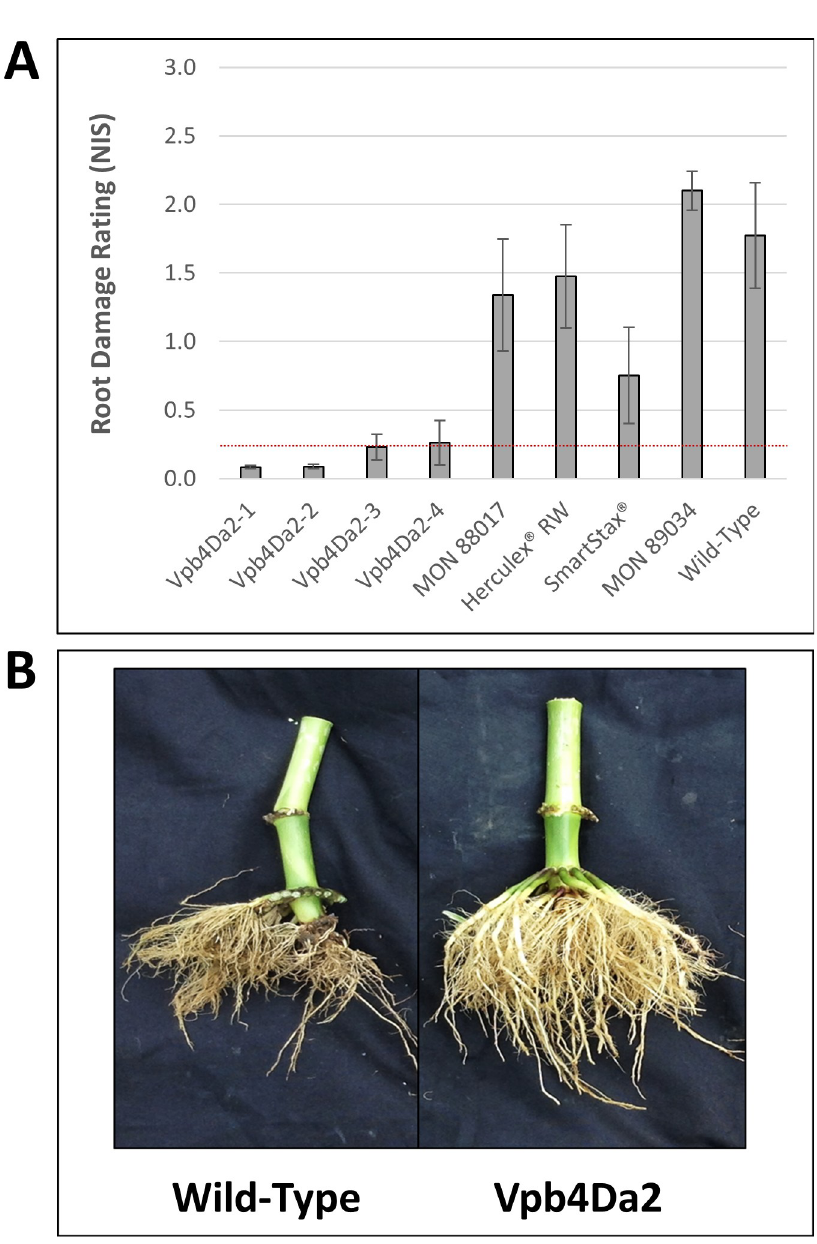
Fig 2. Commercial-level root protection provided by Vpb4Da2 transgenic maize against WCR under field conditions. ( A ) Mean ( ± SEM) NIS scores are shown across two locations with NIS � 1.7 on negative controls including wild-type maize (Colesburg, IA, and Fairbank, IA) in 2017 field root protection trials. Maize lines in the trial were Vpb4Da2-expressing maize, commercial transgenic products including VT Triple PRO 1 carrying MON 88017, Herculex 1 RW, and SmartStax 1 , and negative controls including the commercial lepidopteran-protection trait MON 89034 and wild-type maize. Dotted line in red color shows the commercial threshold of NIS 0.25, error bars represent SEM. ( B ) Examples of roots from Vpb4Da2 transgenic maize and the wild-type maize control from Shelby, NE in 2017 field root protection trials.